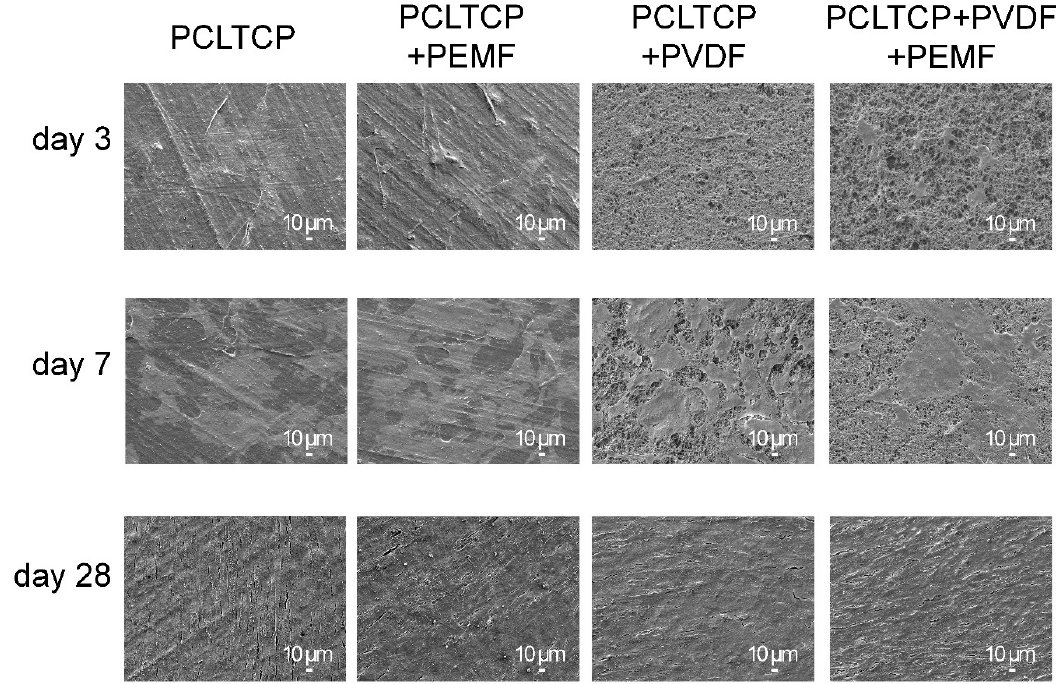
Figure 3. Fixed cell morphology on PCL-TCP without (PCL-TCP) and with pulsed electromagnetic field (PEMF) (PCL- TCP+PEMF) and on PVDF-coated PCL-TCP without (PCL-TCP+PVDF) and with PEMF (PCL-TCP+PVDF+PEMF) observed using SEM on day 3, 7, and 28.